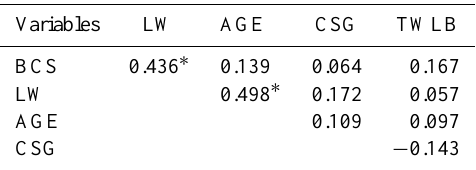
Table 3. Least-squares means ( ± SE) of colostral specific grav- ity (CSG) and ewe live weight according to body condition score (BCS) at lambing and age of ewe.